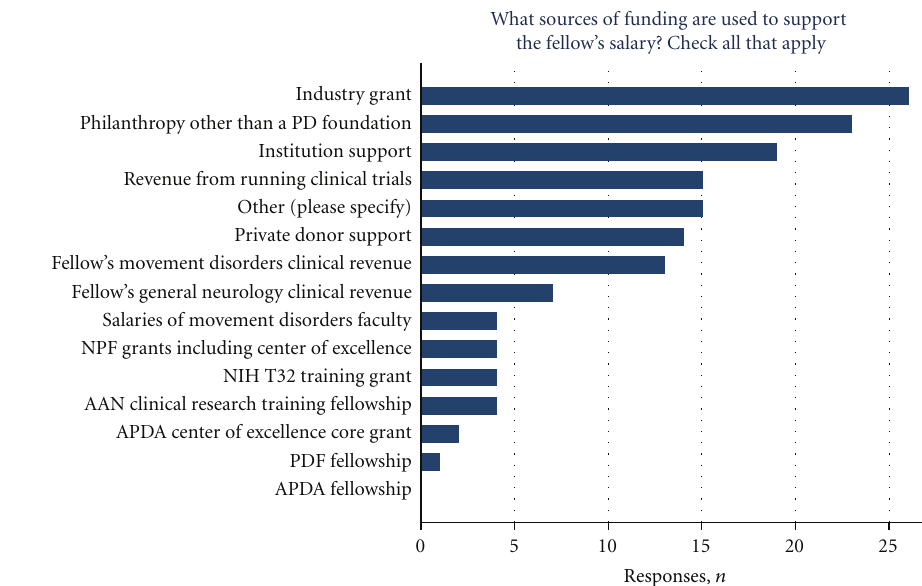
Figure 4: Sources of funding for fellowship support. Other responses include Parkinson Society of Canada, Dystonia Medical